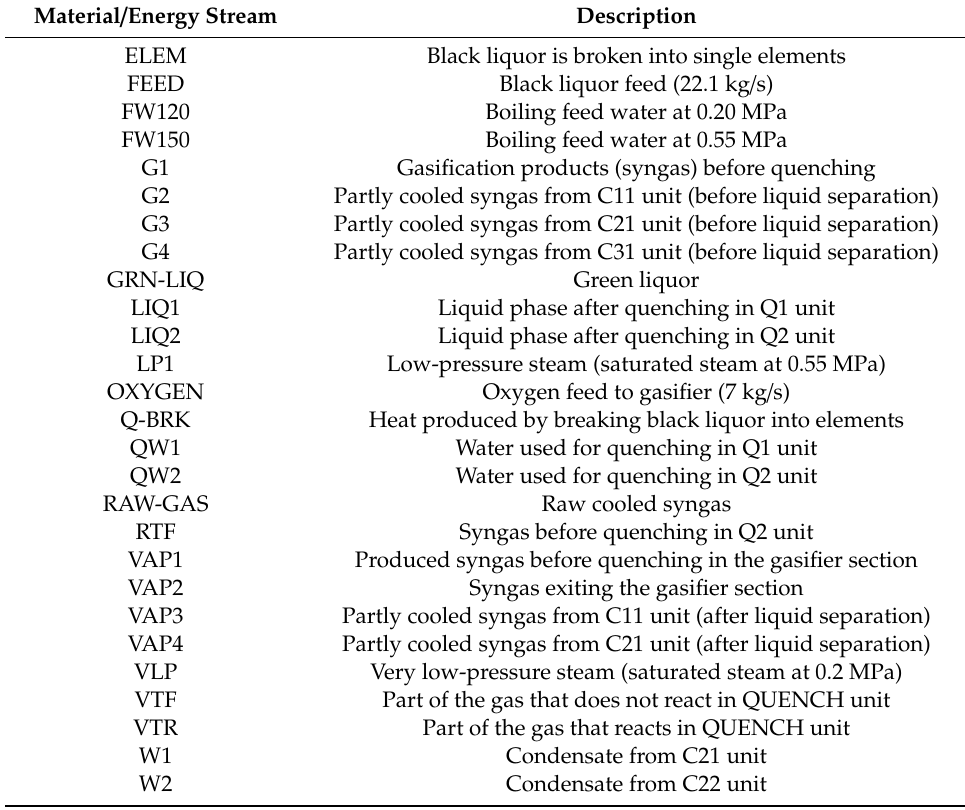
Table 4. Material and energy streams shown in Figure 2.